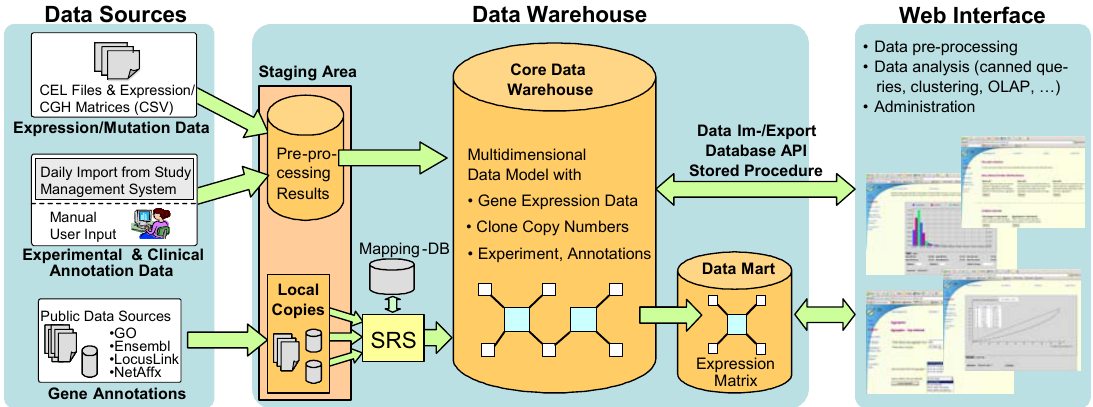
Figure 1: Overall architecture of